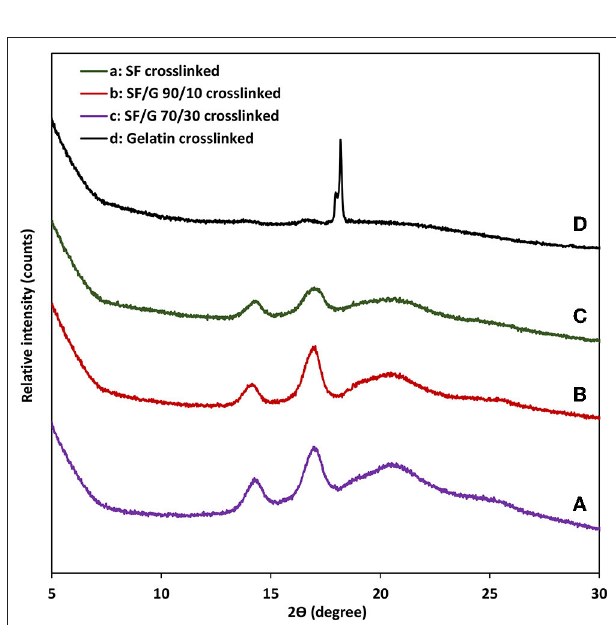
FIGURE 5 | XRD patterns of GTA crosslinked nanofiber mats: (A) SF, (B) SF/gelatin at the blend ratio of 90/10 (C) SF/gelatin at the blend ratio of 70/30, and (D) gelatin. “SF/G” represents silk fibroin/gelatin.